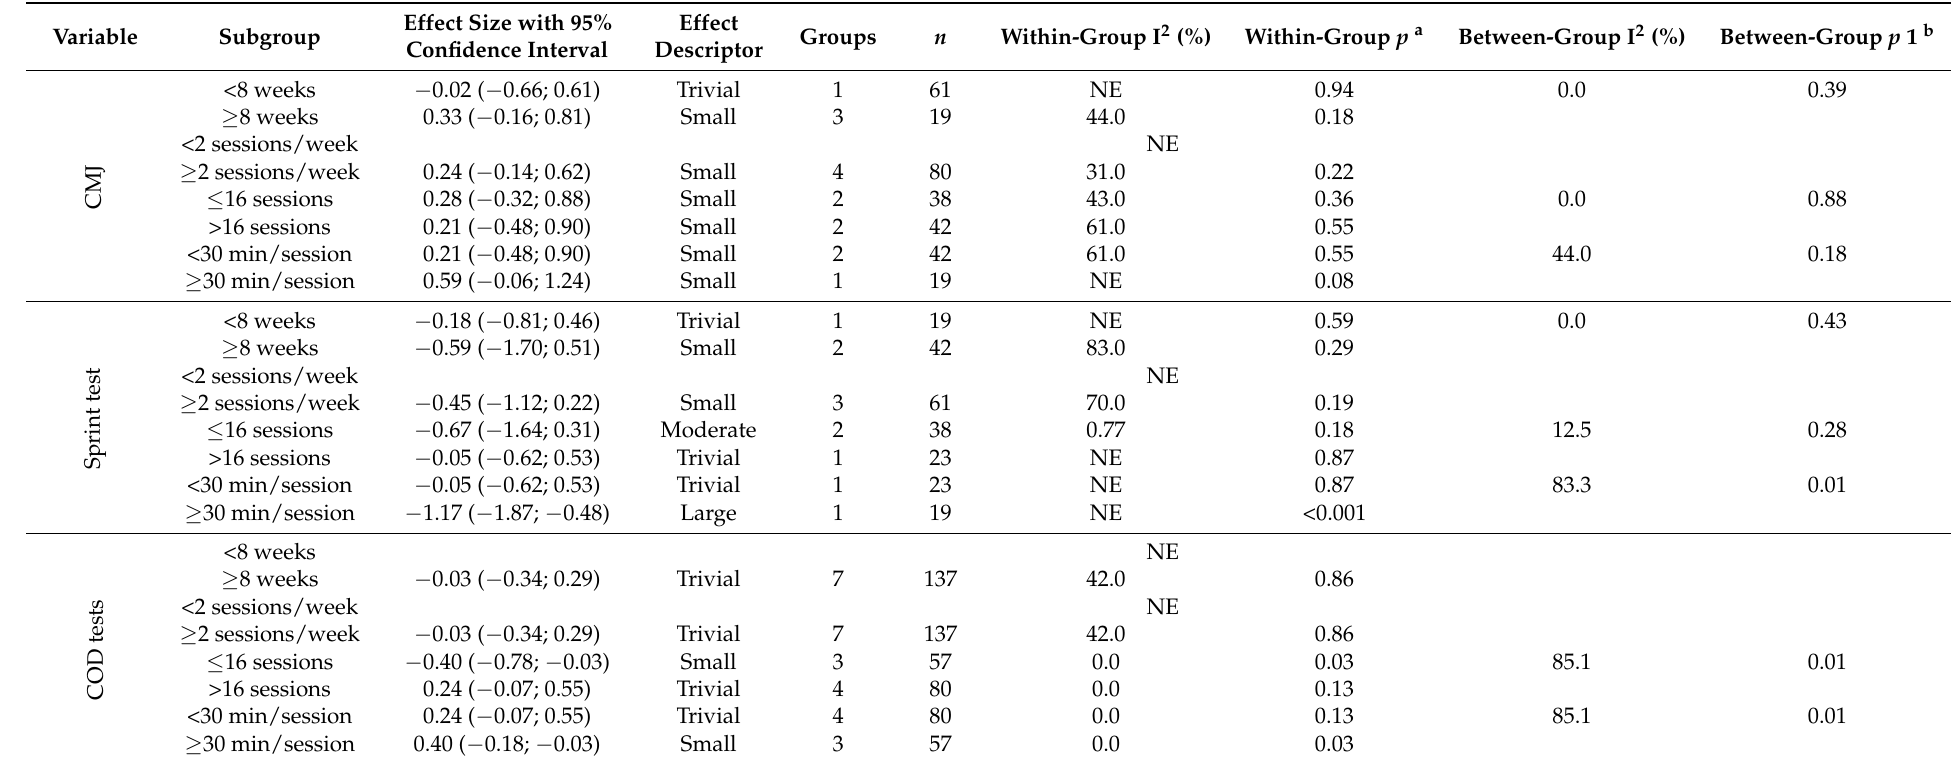
Table 4. Effect of moderator variables with 95% confidence intervals in strength